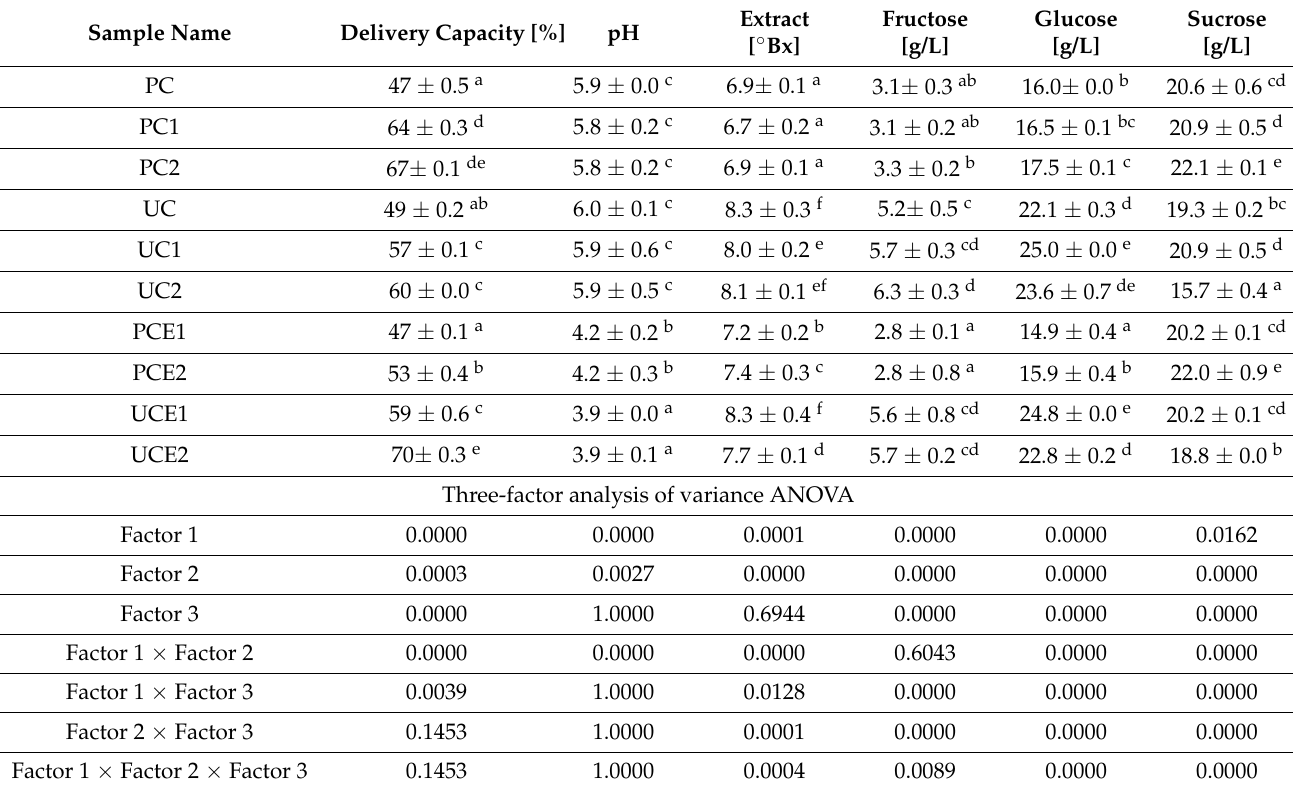
Table 1. Effect of pectinase on celeriac pulp on pressing yield, pH, content of total soluble solids, and selected